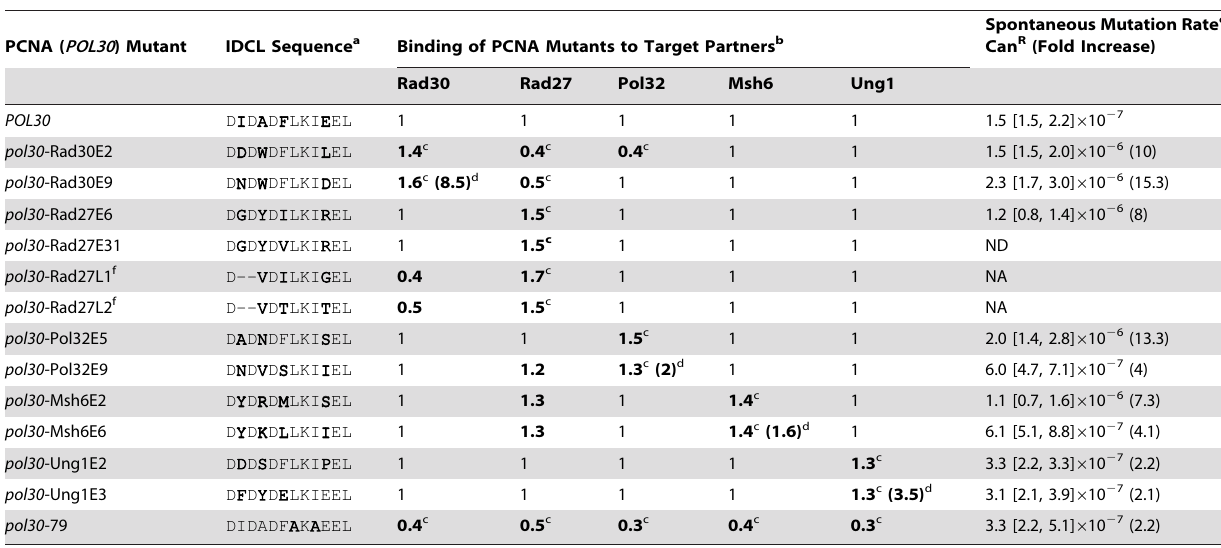
Table 1. Summary of the in vitro and in vivo characterization of PCNA mutants.